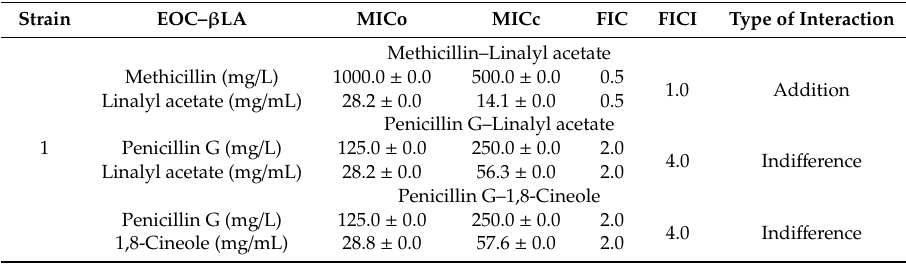
Table 3. Fractional inhibitory concentration (FIC) and FIC indices (FICIs) of pairs of essential oil compounds (EOCs) and β -lactam antibiotics ( β LAs) against MRSA